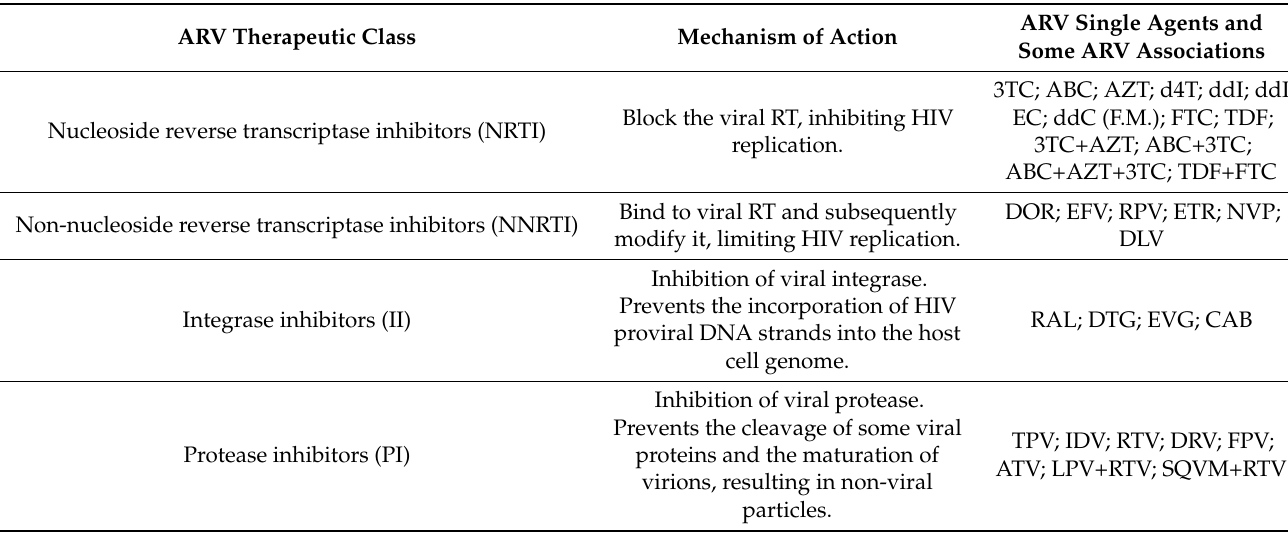
ARV Therapeutic Class Mechanism of Action